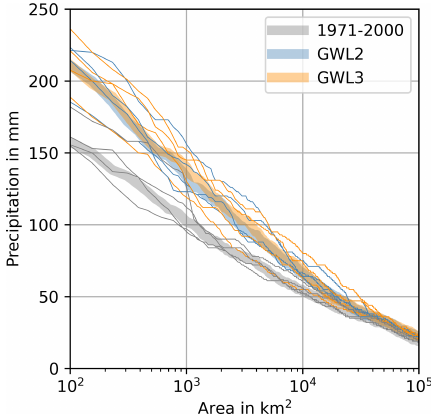
Figure 12. Spatial extent of daily precipitation clusters (contiguous grid points) above the RL10 estimated from the KIT-KLIWA data set for the present-day reference period, GWL2, and GWL3. Thin lines represent individual ensemble members and thick lines the en- semble